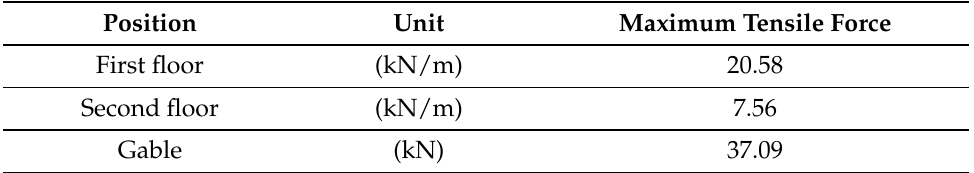
Table 4. Maximum tensile force demands on the anchors of the first storey, second storey, and gable of the model with connections retrofitted for the PGA of 0.63